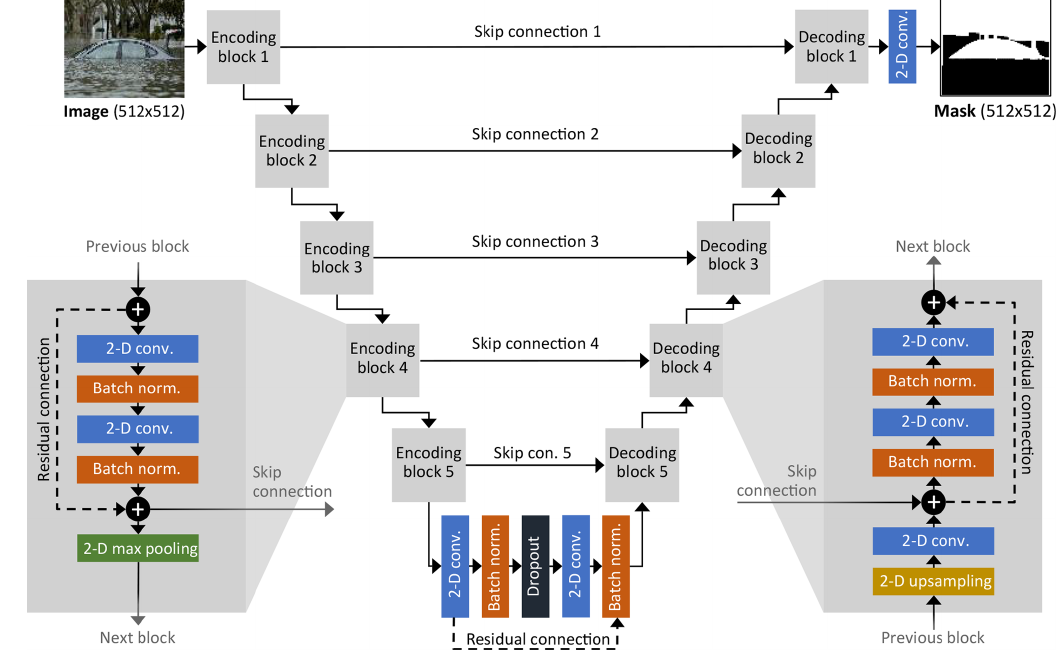
Figure 2. The deep convolutional neural network architecture used to perform water segmentation.